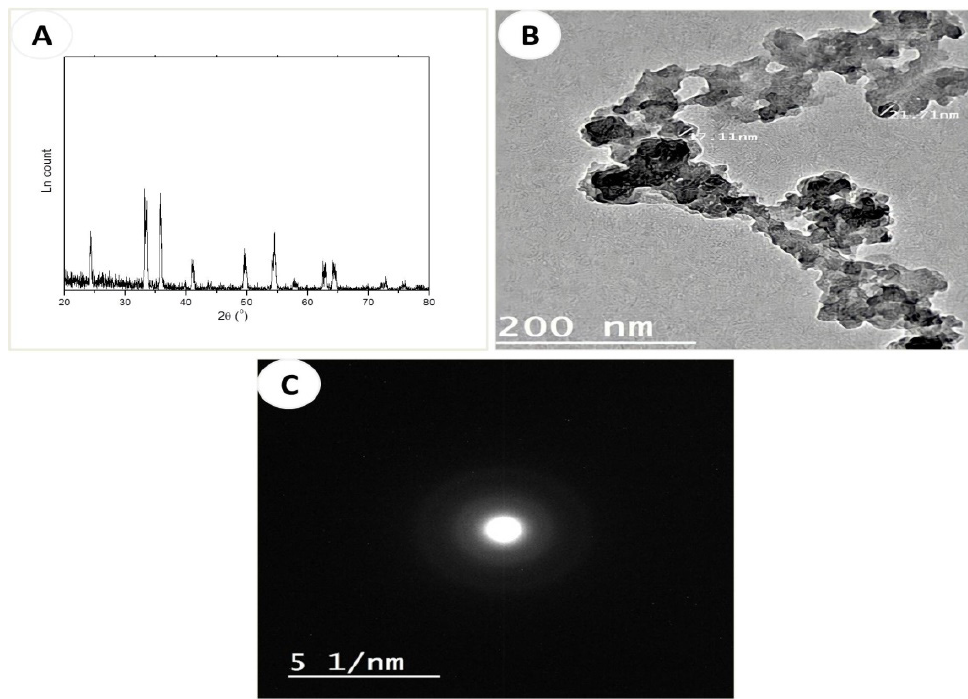
Figure 2. Characterization of Fe 2 O 3 -NPs including: ( A) XRD, ( B ) TEM image, and ( C ) SAED of Fe 2 O 3 - NPs. Fe 2 O 3